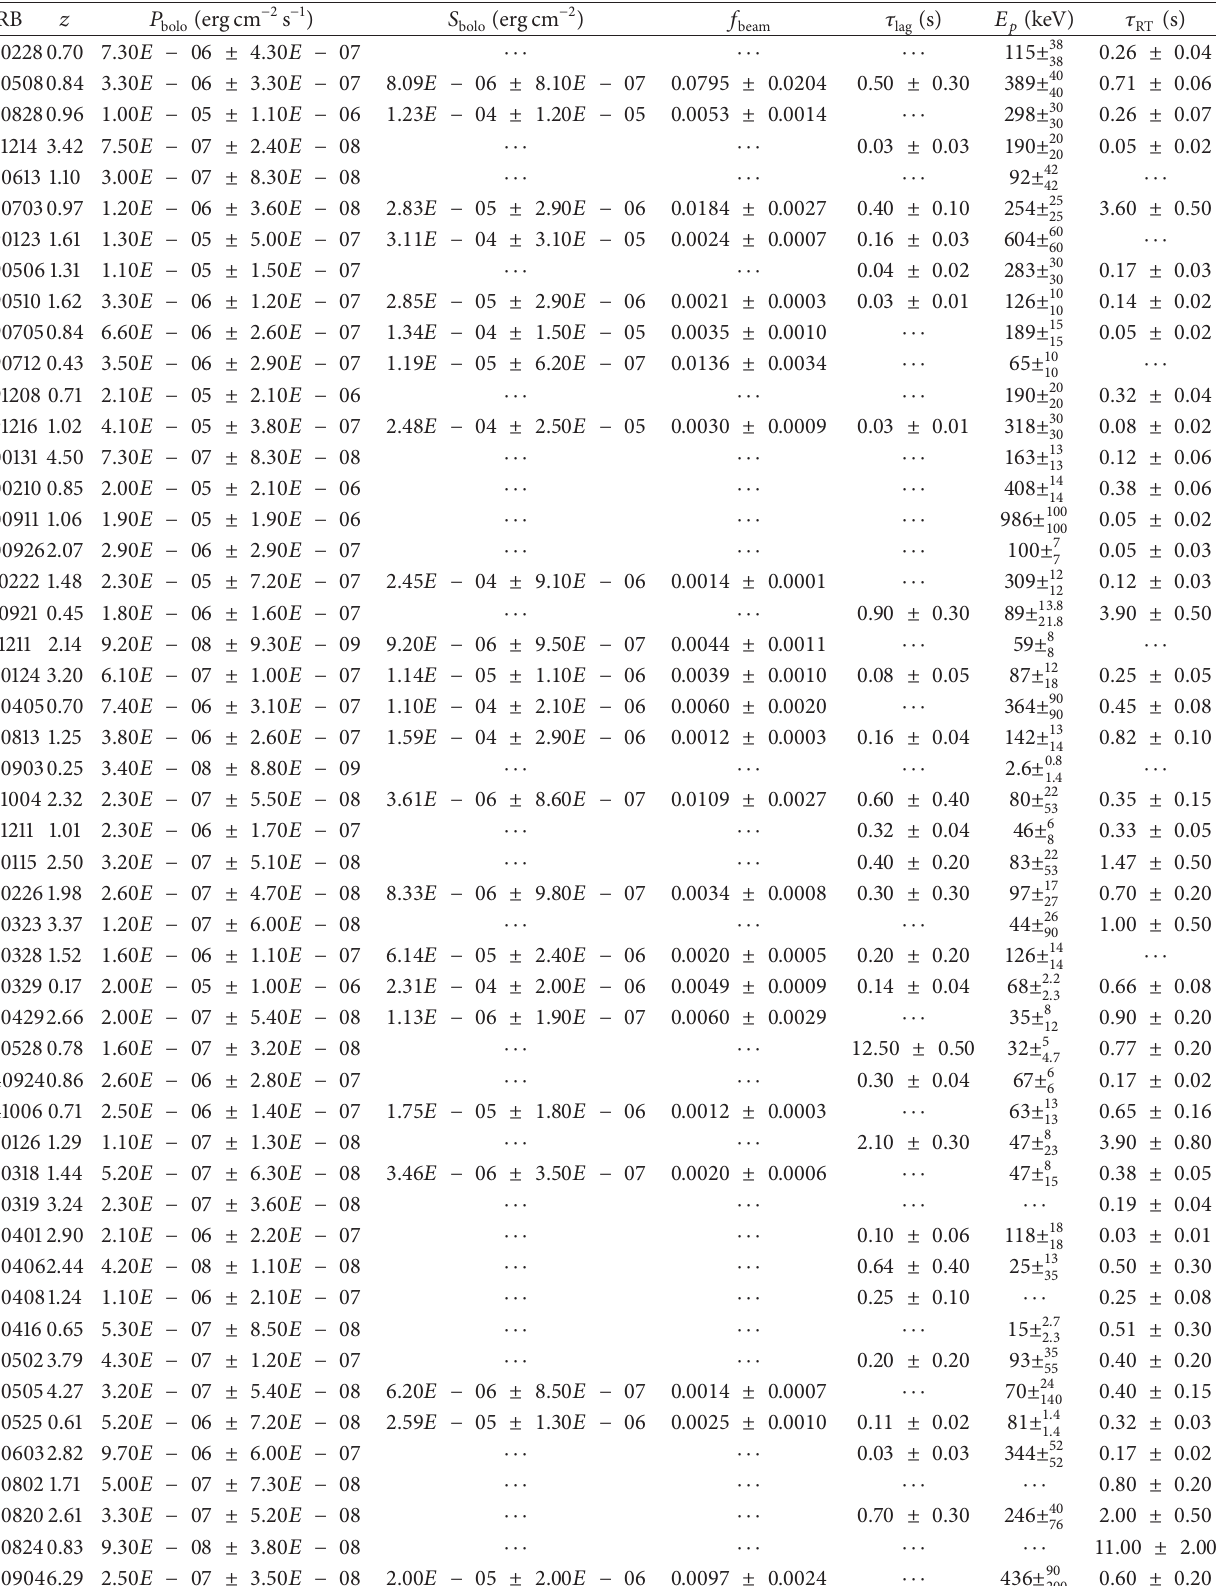
Table 1: Luminosities and luminosity